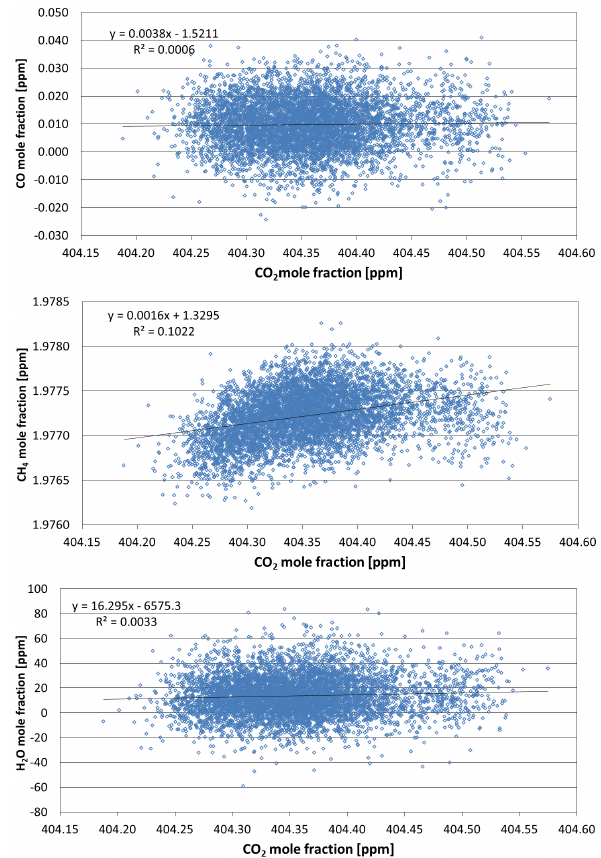
Figure 5. Decanting experiment within 8h: no effect of CO and H 2 O can be detected given the limitations of the analyser’s signal- to-noise ratio at that level on the aluminium cylinder compared to the CO 2 mole fraction.